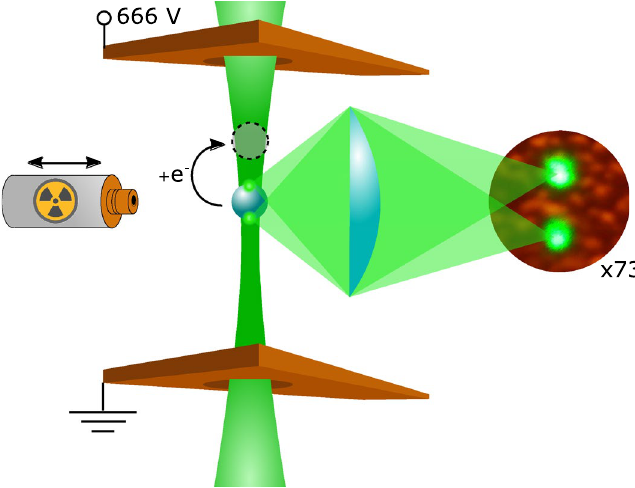
Figure 1. Schematic of the experimental setup. A silicone oil droplet is levitated between two flat, horizontal electrodes with a separation of 1.0 mm and a voltage difference of 666 ± 0.5 V. A 241 Am alpha radiation source is placed close to the droplet in order to create free electrons. Some of these electrons become attached to the droplet and change its net charge. The levitated droplet scatters mostly from the bottom and top where the laser enters and exits the droplet. This creates a double point image when focused by a